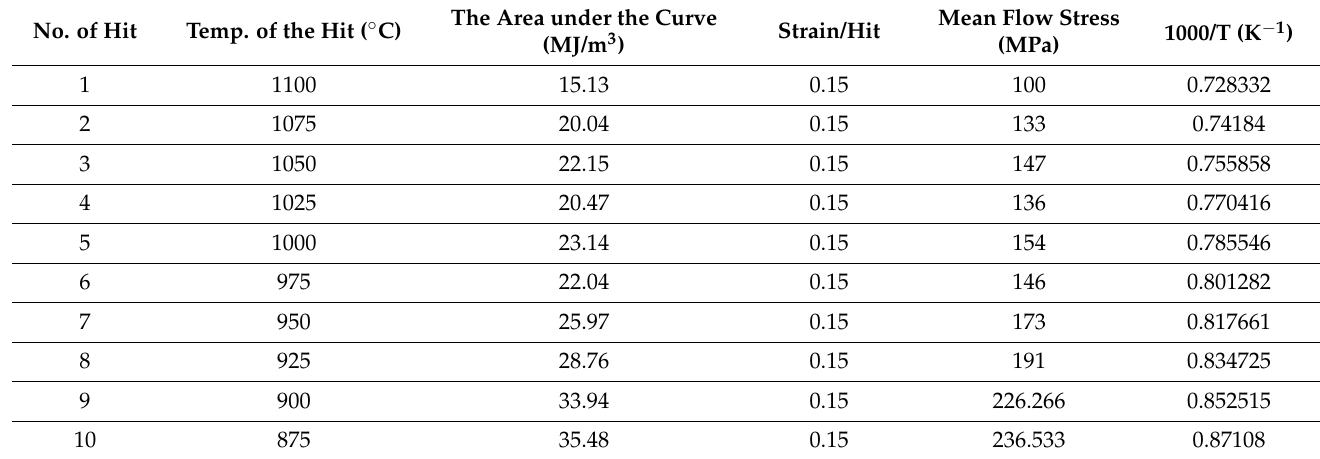
Figure 6. Stress-strain diagram with the area under the curve. Table 3. Quantitative results of the compression test in